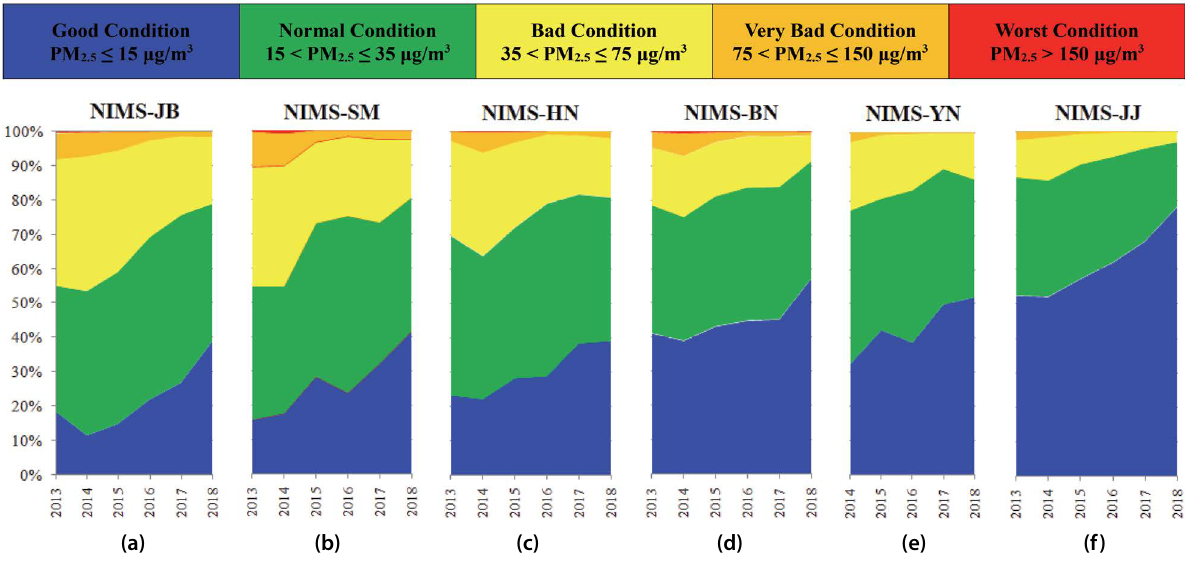
Fig. 4. Annual trends of PM